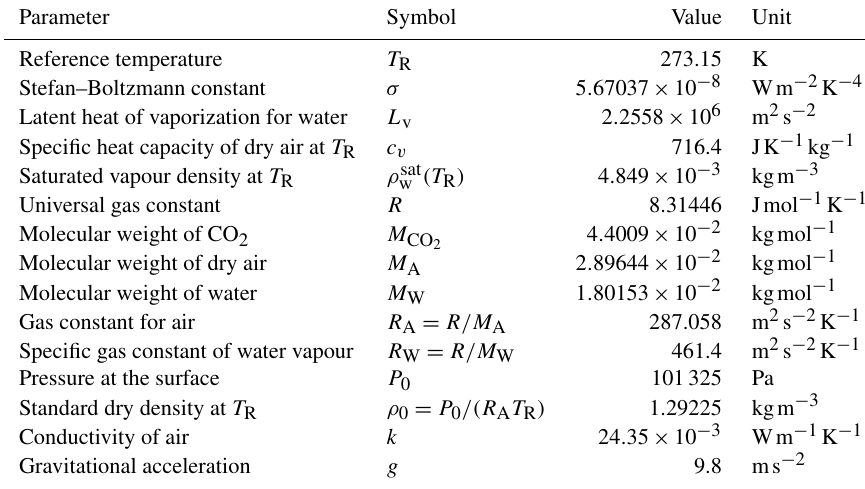
calibration attempted to match estimates from Schmidt et al.